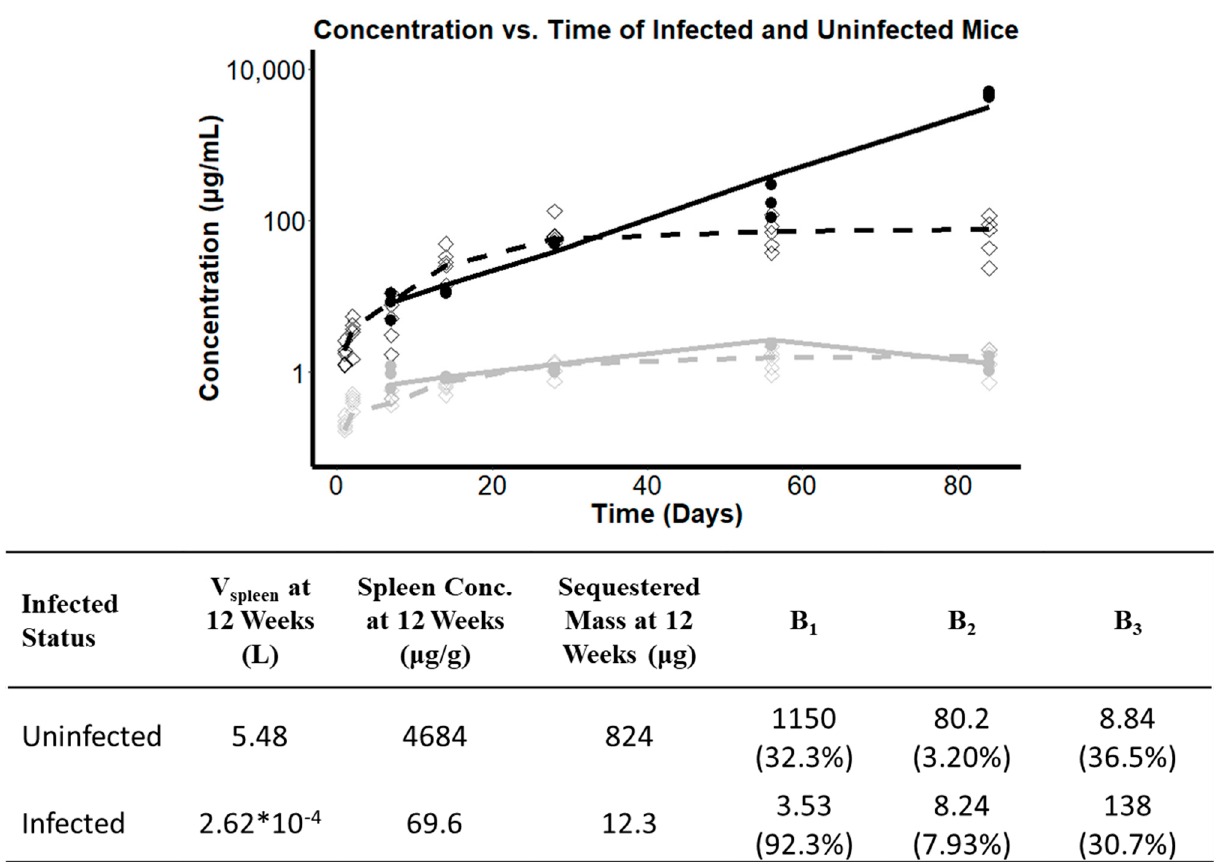
Figure 6. Concentration over time profile in the serum (grey) and spleen (black) over 12 weeks of dosing in mice administered 25 mg/kg/day. Concentration predictions in uninfected mice (solid lines) are shown alongside observed values (solid circles). Concentration predictions in M. tuberculosis infected mice (dashed lines) are shown alongside observed values (diamonds). The accompanying table compares the expansion function parameters alongside the relative volume of distribution, spleen concentration, and mass sequestered after 12 weeks of dosing. CV% are expressed in parentheses below the expansion function parameter estimates.